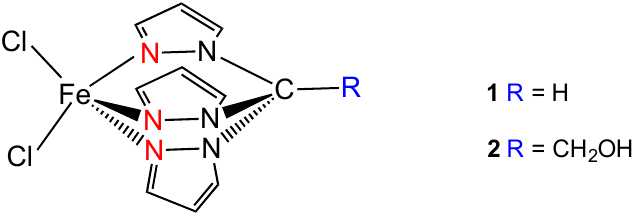
Figure 2. Schematic structure representation of C-scorpionate complexes [FeCl 2 {HC(pz) 3 }] 1 (pz = pyrazol-1-yl) and [FeCl 2 {HOCH 2 C(pz) 3 }] 2 .